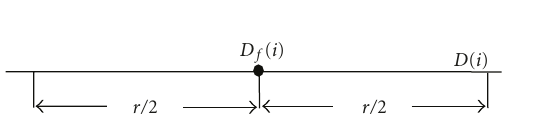
Figure 7: The operation of bit filtering.